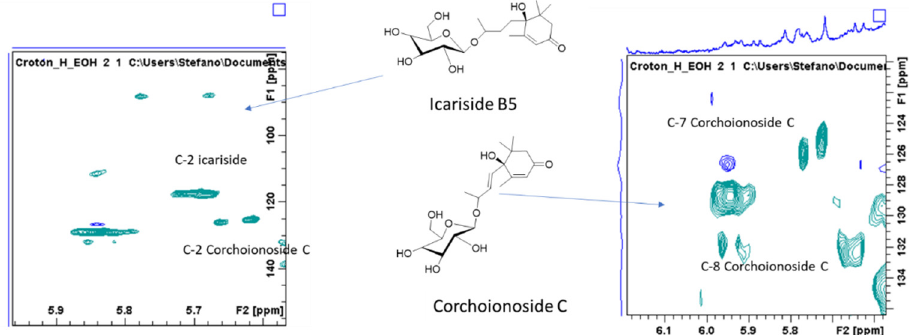
Figure 2. HSQC-DEPT portion of spectrum showing some of the diagnostic signals used to confirm structure identification. Table 1. NMR data obtained from 1D and 2D NMR experiments and assignments of constituents identified in Croton hirtus extract. COSY, correlation spectroscopy.